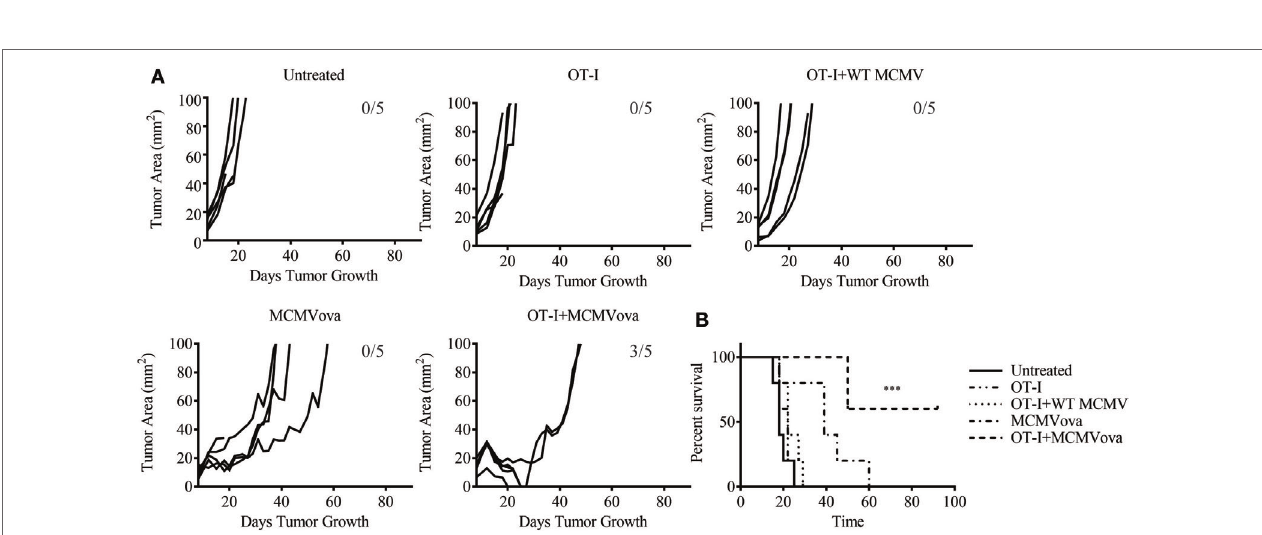
FigUre 2 | Adoptive cell therapy and murine cytomegalovirus (MCMV)-OVA vaccination cures mice of B16ova. Wild-type (WT) mice were challenged with B16ova i.d. and 8 days later were left untreated, treated with 10 5 OT-I cells i.v., treated with 10 5 PFU MCMV-OVA i.p., treated with OT-I transfer i.v. and 10 5 PFU WT MCMV i.p., or treated with OT-I transfer i.v. and MCMV-OVA i.p. (a) Tumor growth curves of individual mice treated as shown. (B) Survival curves for experiment shown in (a) . n = 5 mice. Number of tumor-free mice at end of experiment shown in (a) . Data are representative of three independent experiments. *** p < 0.001.